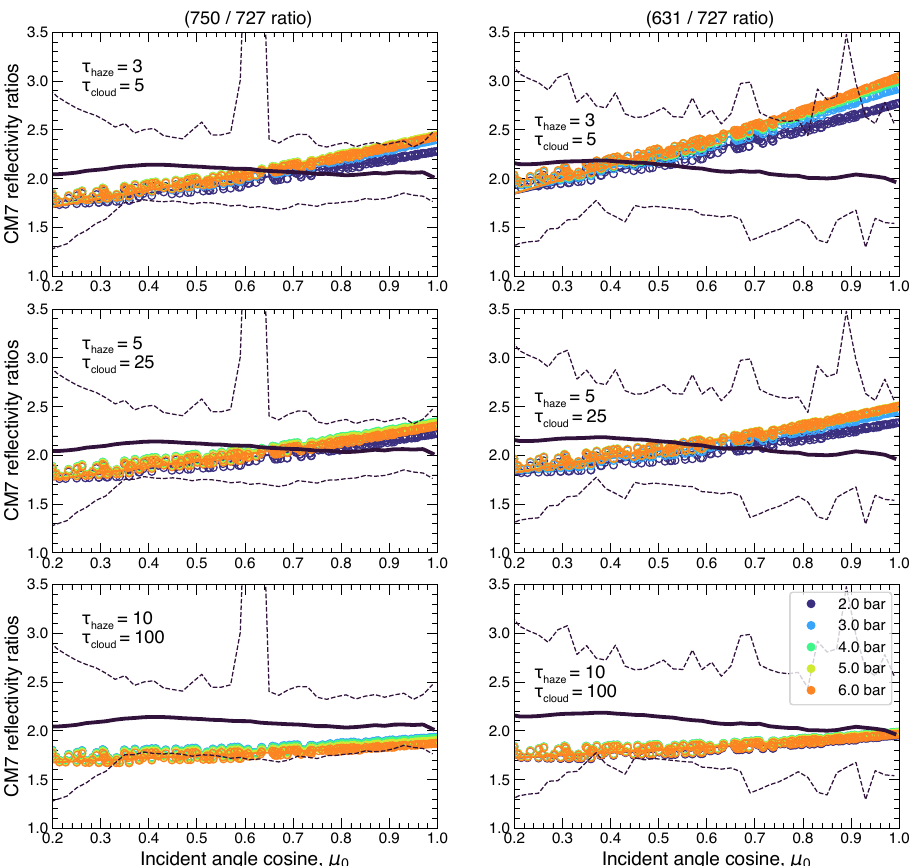
Figure 14. CM7 values are plotted vs. µ 0 for the same model cases as in Fig. 12, for the two continuum filters. With some minor exceptions discussed in the text, most of the model results fall between the dashed lines marking the minimum and maximum values in the data from Fig. 1, so the results are considered Jupiter-like. Sensitivity to deep cloud pressure levels is greater for the 631/727 ratio, perhaps because ammonia gas absorption limits the usefulness of the 750-nm filter as a continuum reference wavelength. General trends support the interpretation that low CM7 values are found where there is high opacity in the upper cloud/haze layer. Deep clouds have a limited ability to increase the CM7 ratio, compared to simply reducing the opacity in the upper haze/cloud layer. Consider first the bottom row, for the case of τ haze = 10 and τ cloud = 100 best matching 535 the maximum I / F values in Fig 12. This case also best matches the minimum CM7 values 536 The simulated CM7 values for moderate incidence angles ( µ 0 > 0.4) for the